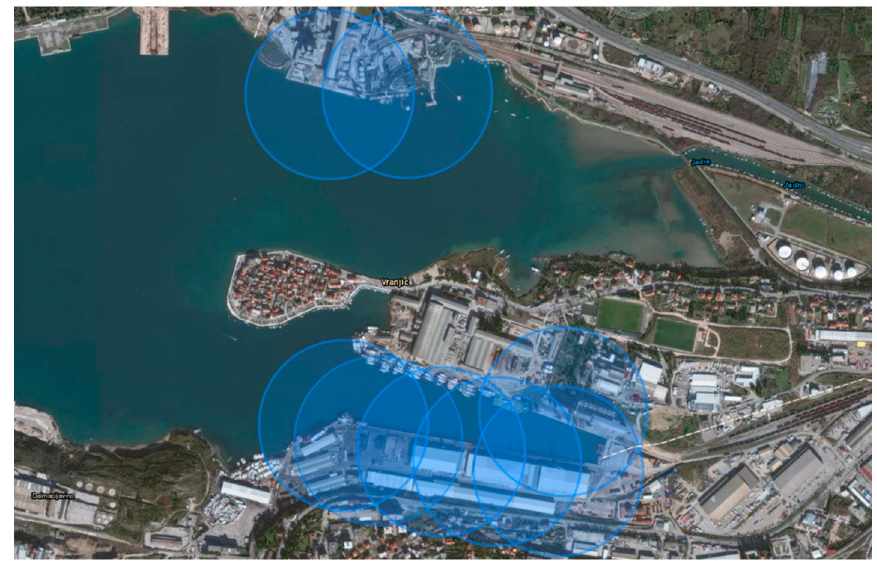
Figure 9. Simulation of Scenario 2 ([46],